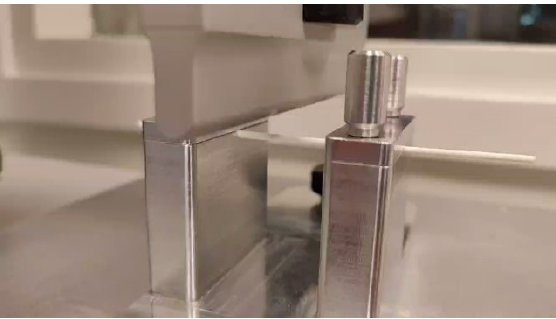
Figure 1. 3 points bending setup with attached filament.